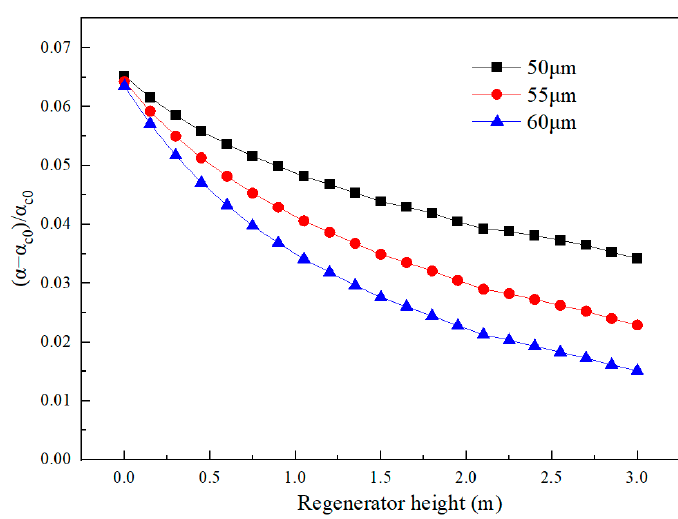
Figure 5. Effects of different diameter dust on heat transfer.